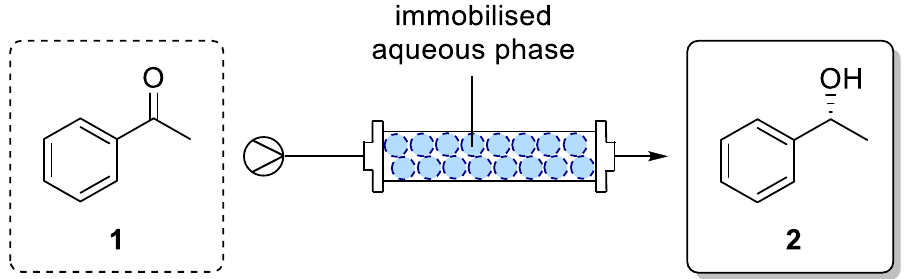
Figure 12. Schematic flow process of enzymatic reduction of acetophenone ( 1 ) to 1-phenylethanol ( R )- 2 using superabsorber-immobilized ADH with GDH-based cofactor regeneration system in a packed bed reactor.